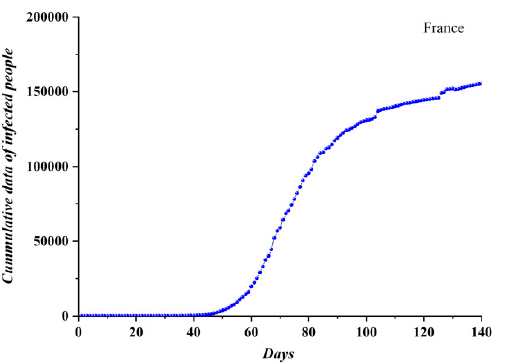
Figure 2. The cumulative COVID-19 infected population in France, as appears in [22]. The plotted period is from 18 February to 28 June 2020.